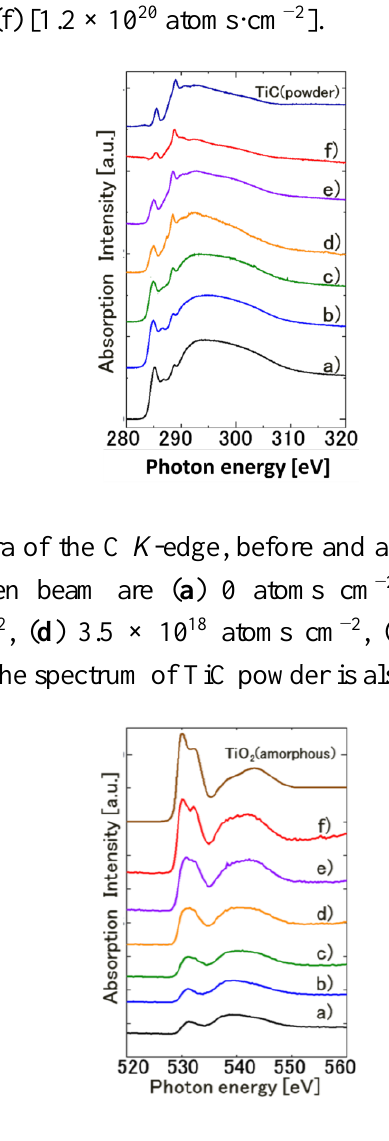
Figure 7. NEXAFS spectra of the O K -edge, before and after exposure to atomic oxygen. Fluences of atomic oxygen beam are ( a ) 0 atoms cm −2 , ( b ) 1.2 × 10 17 atoms cm −2 , ( c ) 1.2 × 10 18 atoms cm −2 , ( d ) 3.5 × 10 18 atoms cm −2 , ( e ) 1.2 × 10 19 atoms cm −2 , and ( f ) 1.9 × 10 20 atoms cm −2 . The spectrum of a TiO 2 amorphous is also shown for